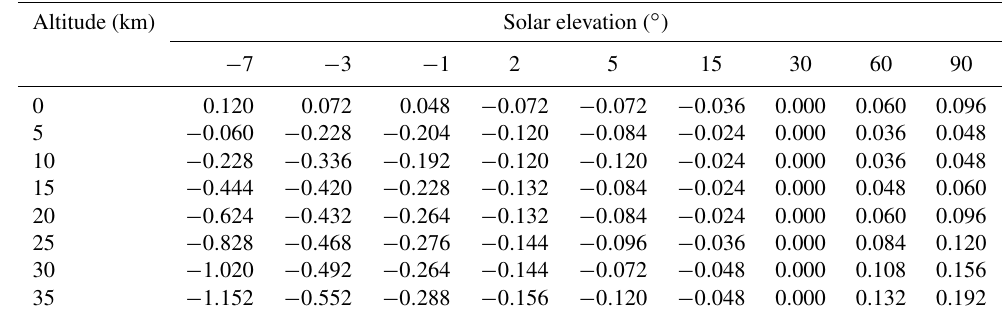
Figure 14. SLWC measured by Anasphere sondes flown on the TBS by altitude and temperature from 2015 to 2017, where N refers to the number of SLWC measurements and the median is shown by the horizontal line. The 25th and 75th percentiles are shown by the bottom and top edges of the box, the whiskers extend to the data points not considered outliers, and outliers are plotted with ’ + ’. Table 2. Solar radiation correction factors applied in SkySonde collection software as a function of iMet radiosonde flight altitude and solar